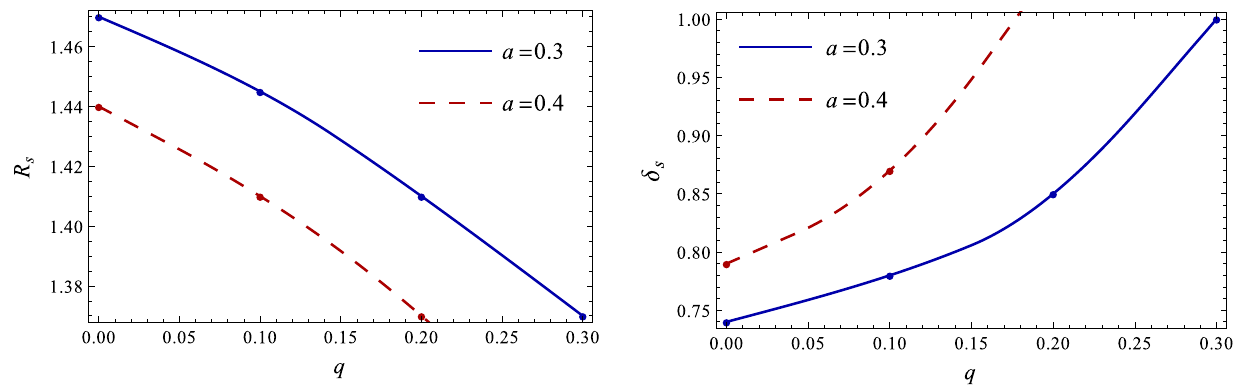
Fig. 7 Plots showing the variation of the radius of the black hole shadow R s and distortion parameter δ s with charge q for different value of spin a